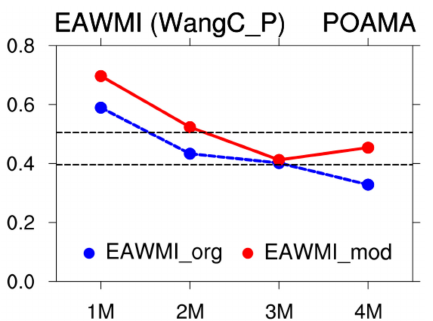
Figure 14. Correlation coefficients between observed and simulated indices from POAMA for different lead months. Red solid line and blue dotted line indicate original and modified index, respectively. And two black dashed lines denote the 99% and 95% confidence level,